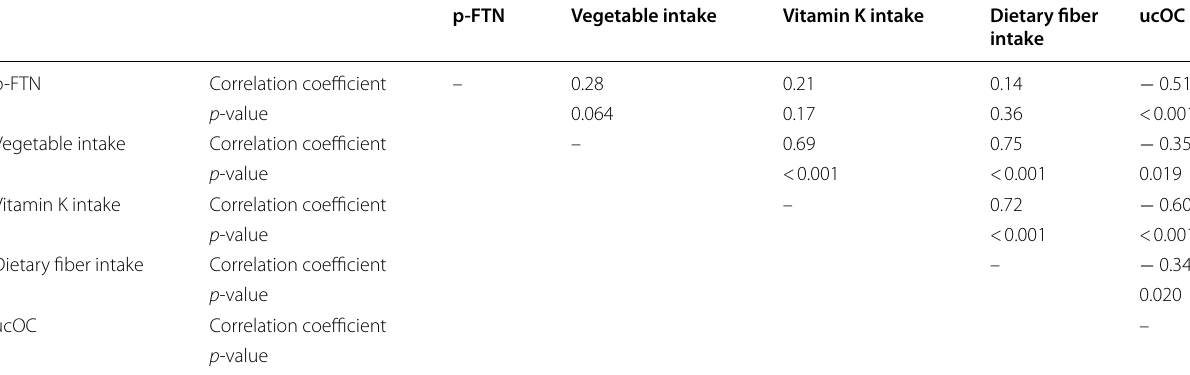
Table 2 Correlations between outcomes (Spearman’s rank correlation coefficient)